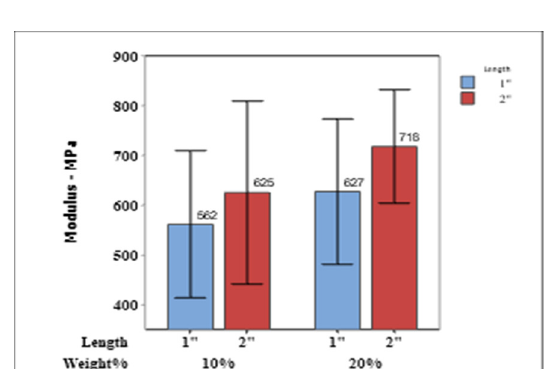
Fig. 7: Comparison of Young’s Modulus of bagasse-